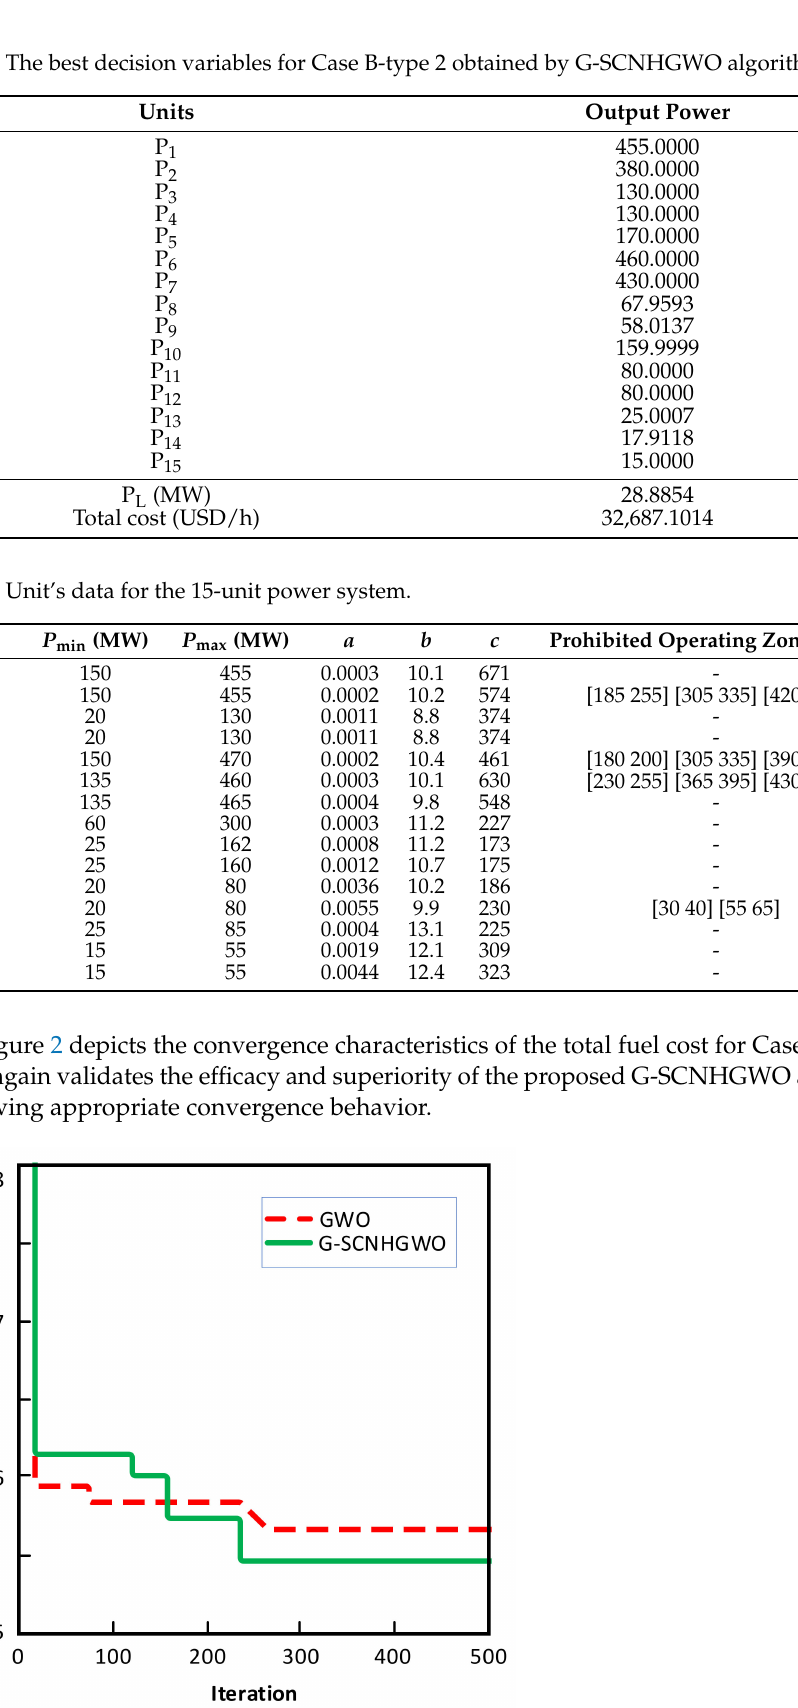
Figure 2. Convergence behavior obtained by GWO and G-SCNHGWO algorithms for Case B-type